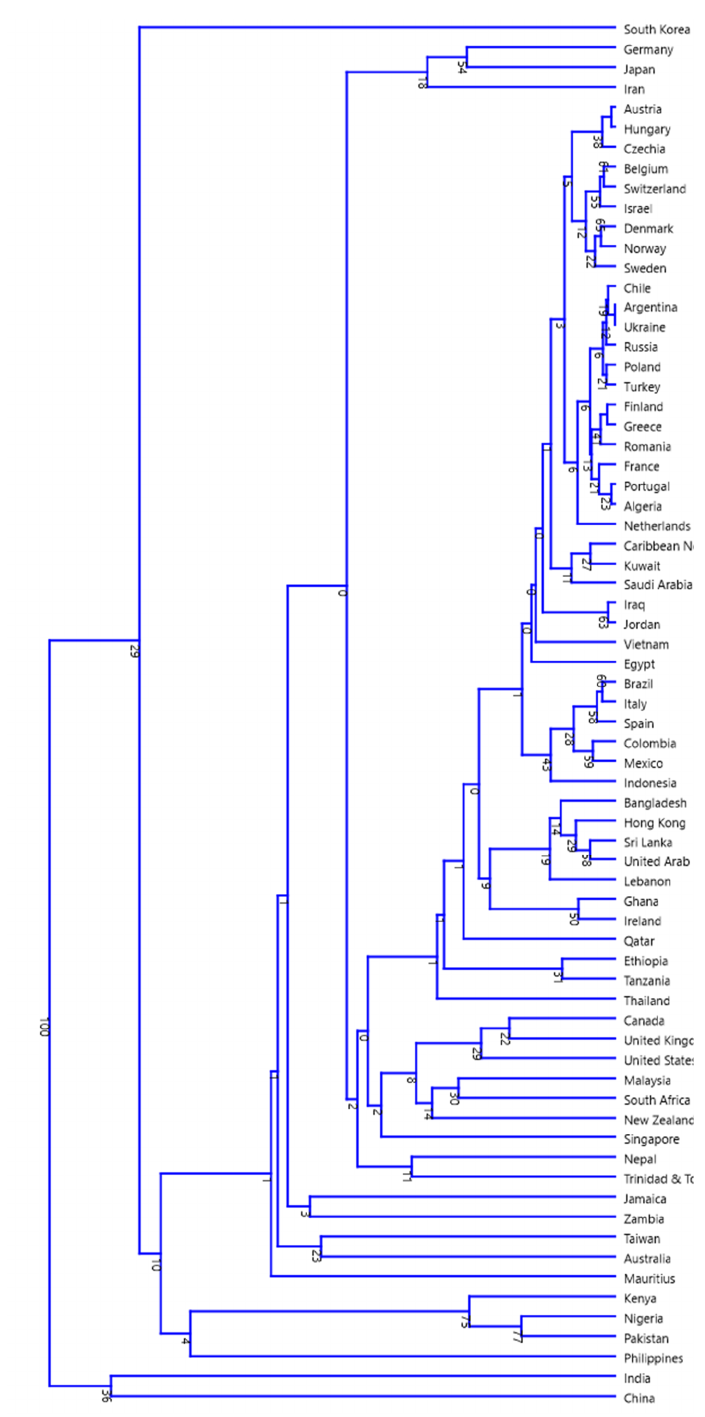
Figure 7. The neighbor- joining tree of the countries associated with phytohormone search. In the tree, India and China grouped together in one cluster, whereas South Korea fall alone in the other cluster. The African country Kenya and Nigeria grouped with Pakistan. Similarly, Germany, Japan, and Iran also fall in one